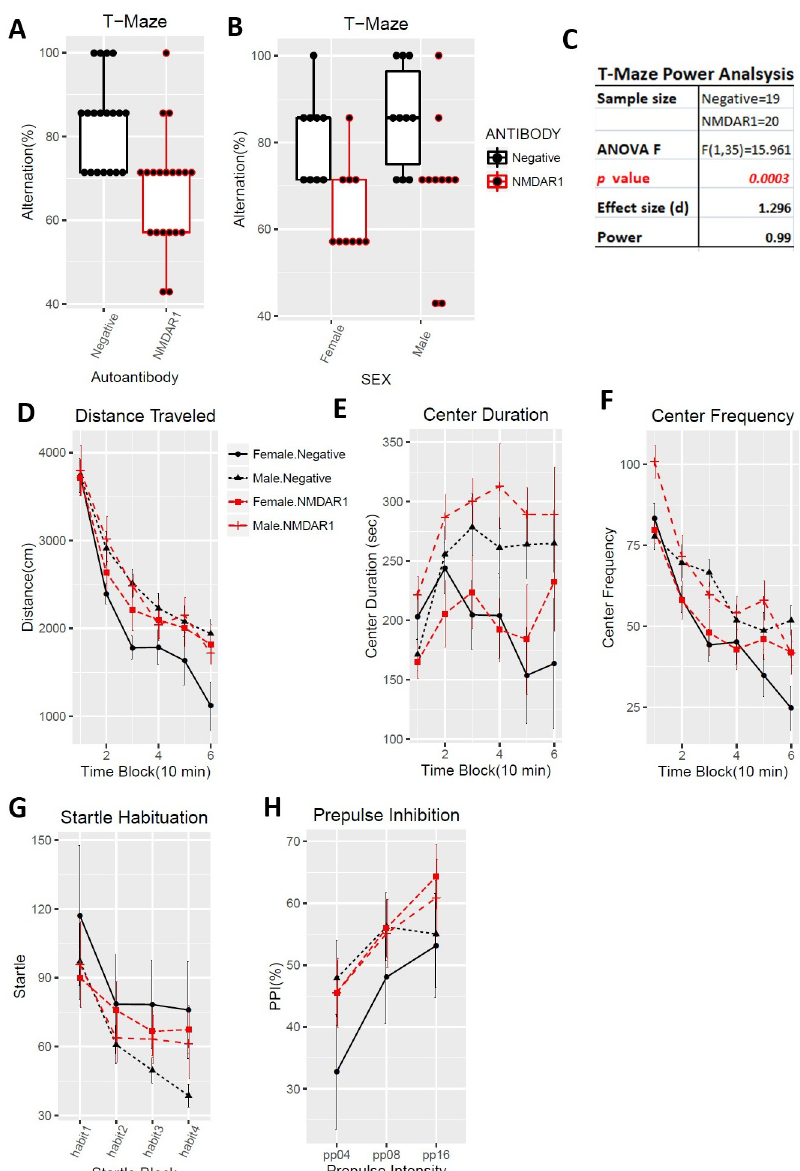
Fig 6. Impaired spontaneous alternation in T-maze. In the large cohort of 40 immunized mice, one female control mice immunized with the CFA only died before behavioral analysis. All other mice are healthy. (A) Alternation percentages of individual mice were present as boxplots. A significant reduction of spontaneous alternation was replicated in the large cohort (F(1,35) = 15.96, p = 0.0003). (B) Both male and female mice carrying the anti-NMDAR1 autoantibodies displayed impaired spontaneous alternation, replicating the T-maze performance of the previous small male cohort. (C) This large cohort of mice provided a sufficient statistical power (0.99) to analyze the effect size (d = 1.296) of the anti-NMDAR1 autoantibodies between the mice with or without the anti-NMDAR1 autoantibodies. (D) There is neither sex (F(1,31) = 2.18, p = 0.15) nor autoantibody (F(1,31) = 0.7, p = 0.41) effect on total distance travelled in the open field. (E) Male mice spent significant more time (F(1,31) = 10.37, p = 0.003) in the center than female mice, but there is no autoantibody effect (F(1,31) = 1.05, p = 0.31). (F) Consistent with the center time, a significant more center frequency (F(1,31) = 6.38, p = 0.017) was observed in male mice. There is no effect of the autoantibody (F(1,31) = 0.99, p = 0.33). (G) There is neither sex (F(1,35) = 1.11, p = 0.3) nor autoantibody (F(1,35) = 0.01, p = 0.93) effect on startle habituation. No interactions between startle block and the autoantibody (F(3,105) = 1.57, p = 0.2). (H) Neither sex (F(1,35) = 0.3, p = 0.57) nor the autoantibody (F(1,35) = 0.93, p = 0.34) effect was observed in PPI. All data are present as